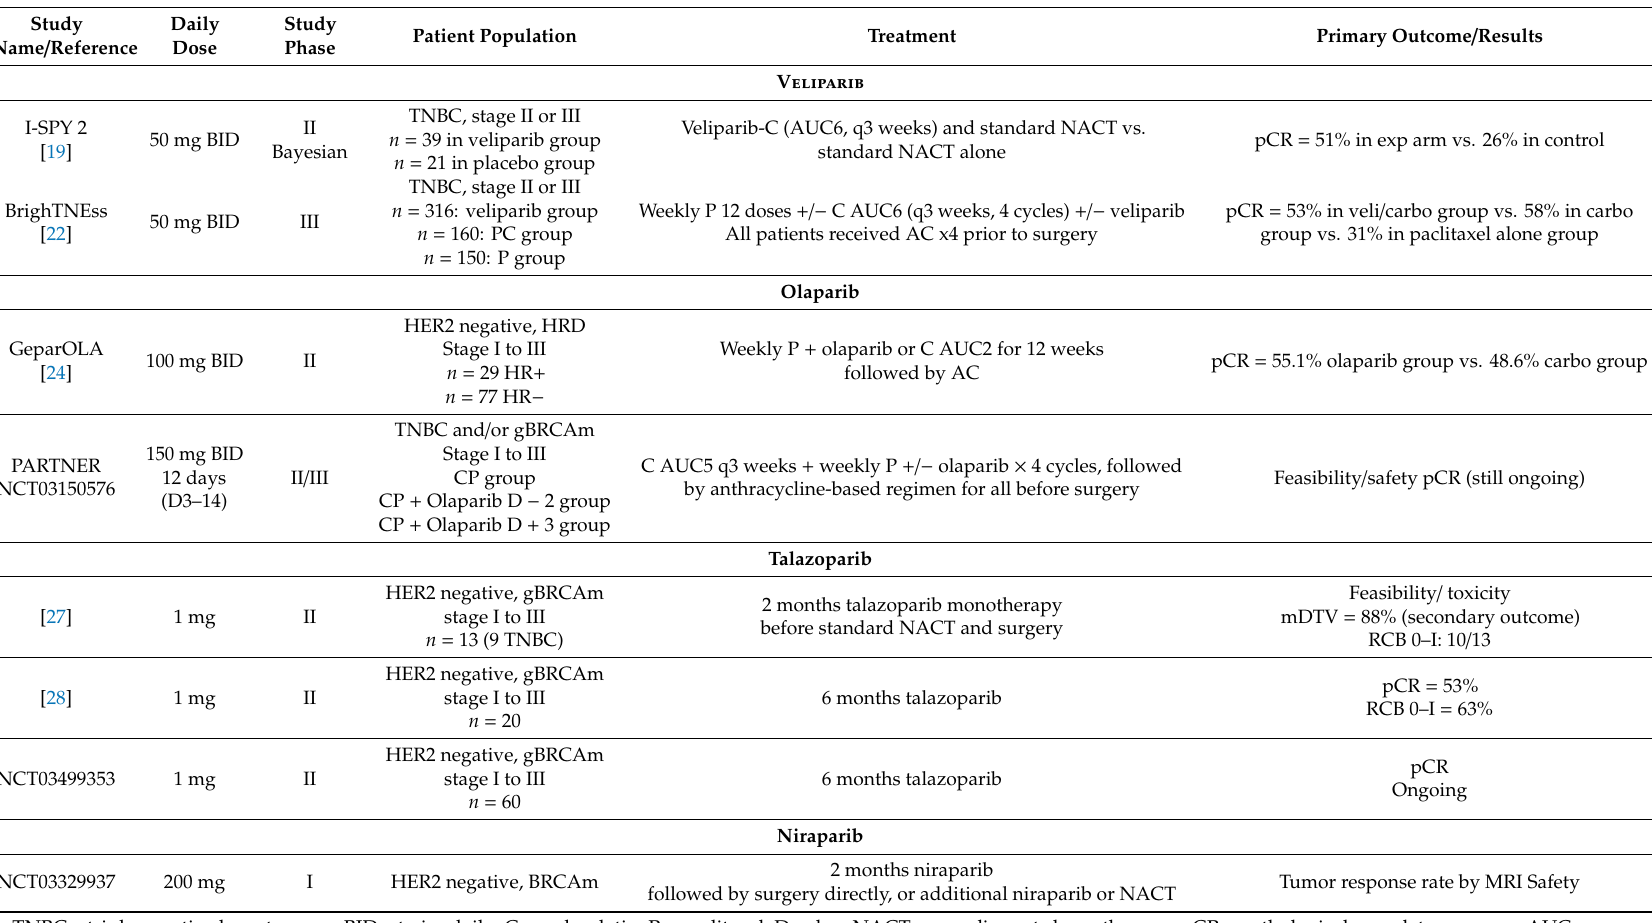
Table 2. Completed and ongoing clinical trials testing PARPi in the neoadjuvant setting in early breast